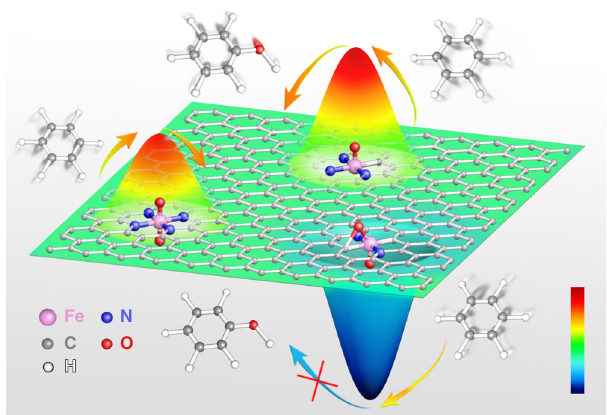
Fig. 1 Schematic illustration. The coordination effect of single-atom Fe-N x C y catalytic sites for benzene